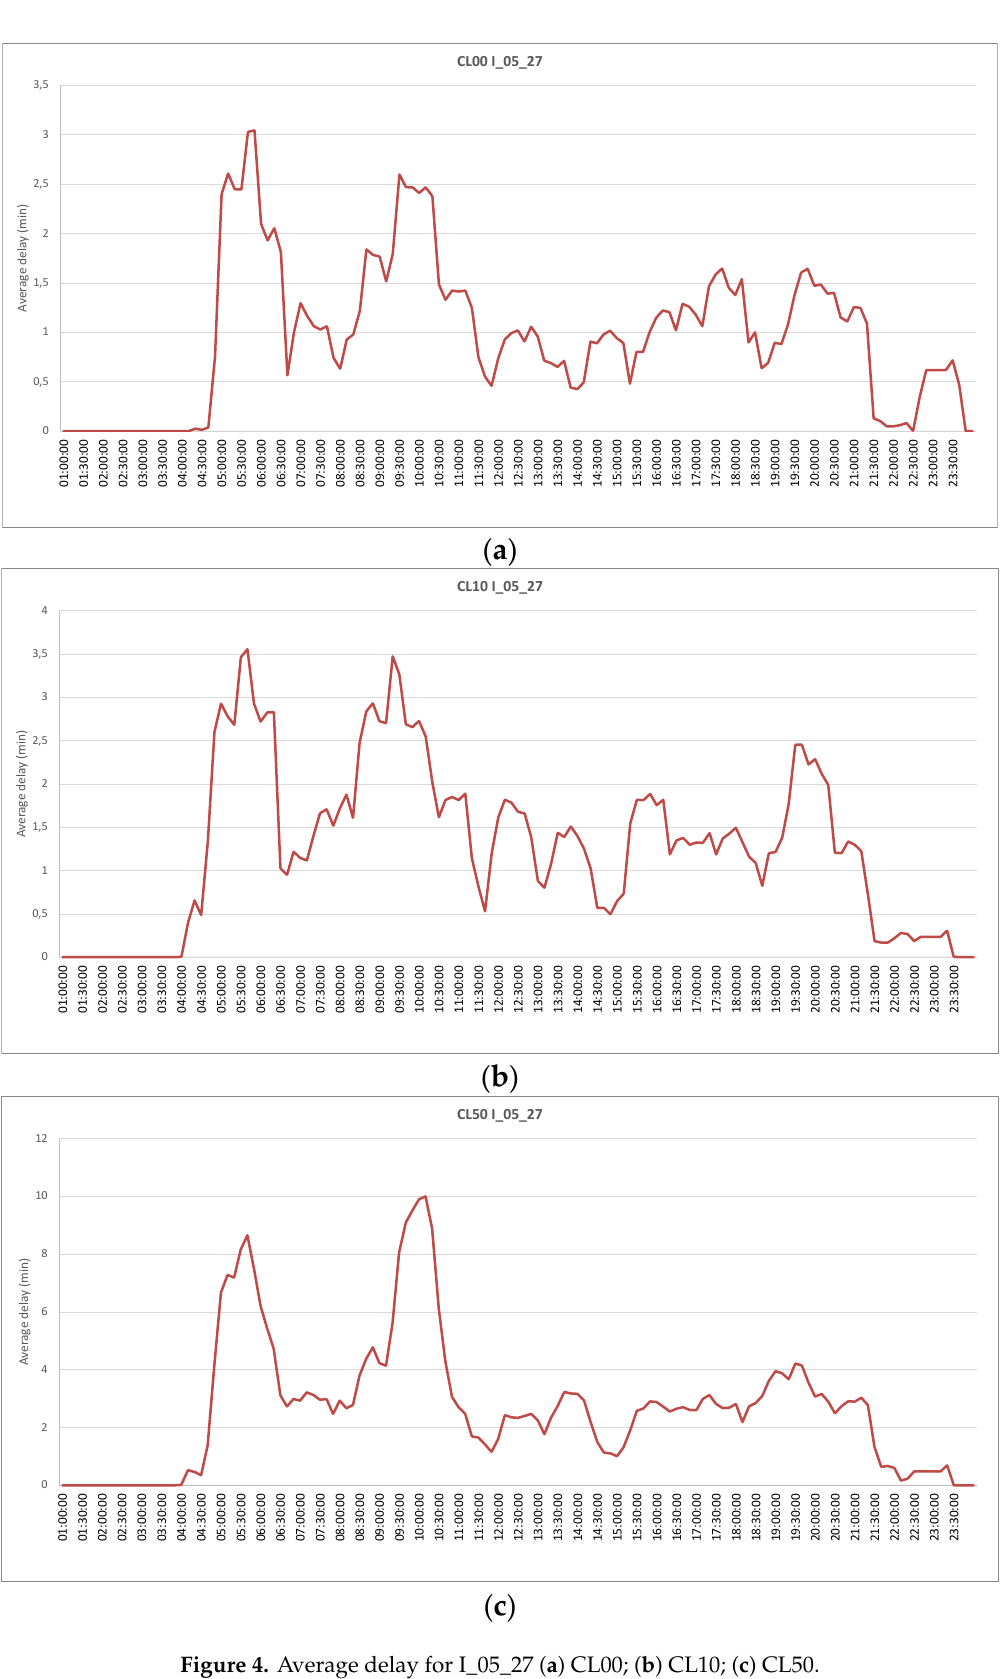
Figure 4. Average delay for I_05_27 ( a ) CL00; ( b ) CL10; ( c ) CL50.